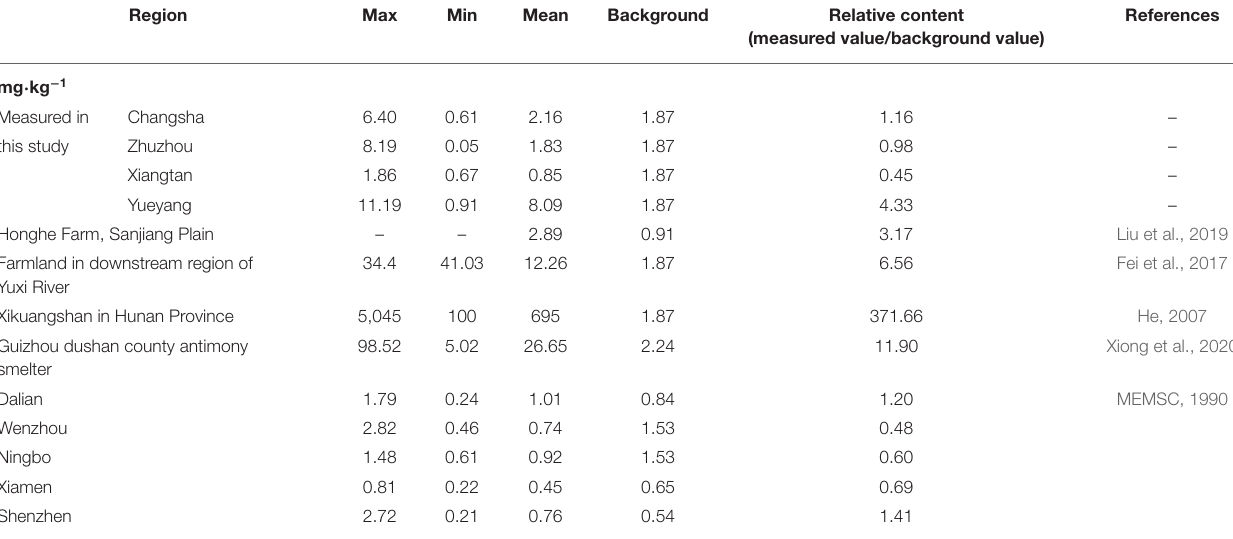
TABLE 2 | Comparison of Sb in topsoil from different regions. Region Max Min Mean Background Relative content